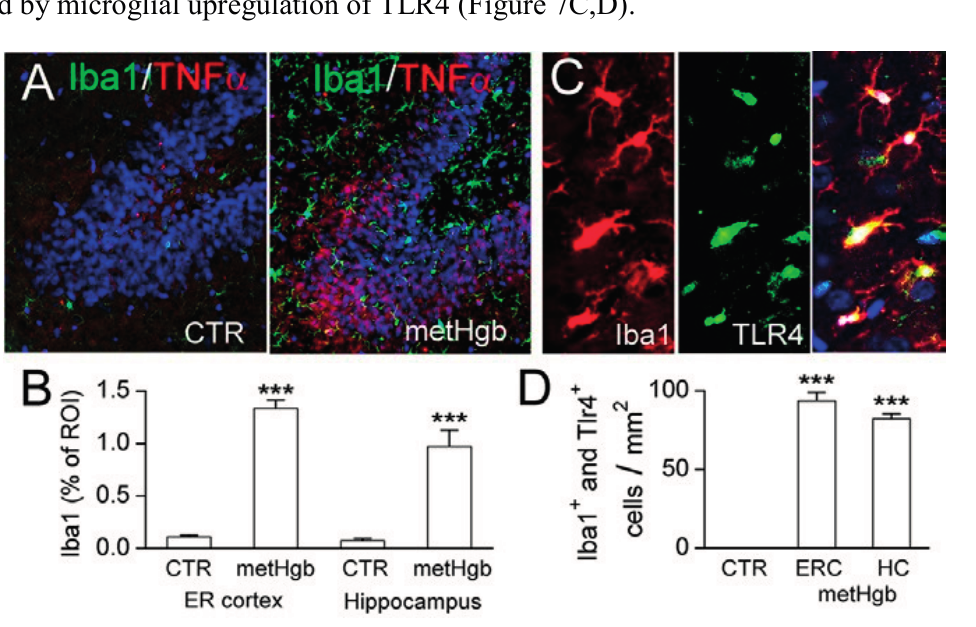
Figure 7. Infusion of highly purified LPS-free metHgb into the subarachnoid space of the entorhinal cortex induces robust neuroinflammation. ( A ) Immunolabelings for Iba1 (green) and TNF α (red) in hippocampus in control brain ( left panel) and after metHgb infusion ( right panel); ( B ) Quantification showed robust upregulation of Iba1 in both the entorhinal (ER) cortex and in the hippocampus, compared to controls (CTR); 3 rats per group; *** p < 0.001; ( C ) Immunolabelings for Iba1 (red) and TLR4 (green) in hippocampus after metHgb infusion; merged images also are shown (right panel); ( D ) Quantification showed marked increases in cells co-expressing Iba1 and TLR4 in the entorhinal cortex (ERC) and in the hippocampus (HC), compared to controls